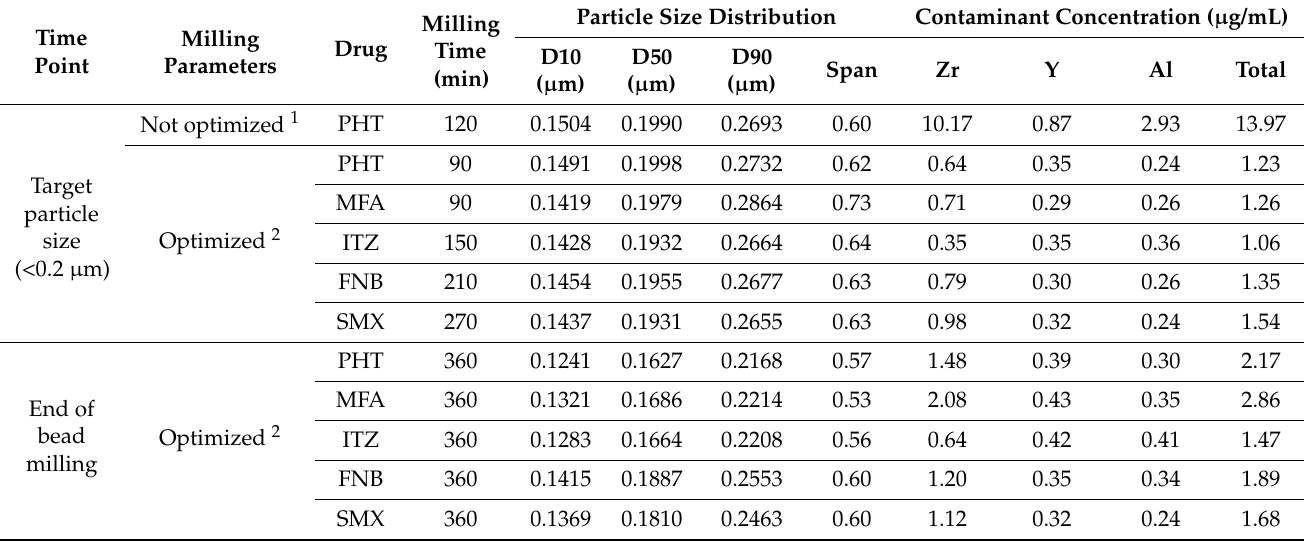
Table 3. Metal contamination after bead milling with the optimized